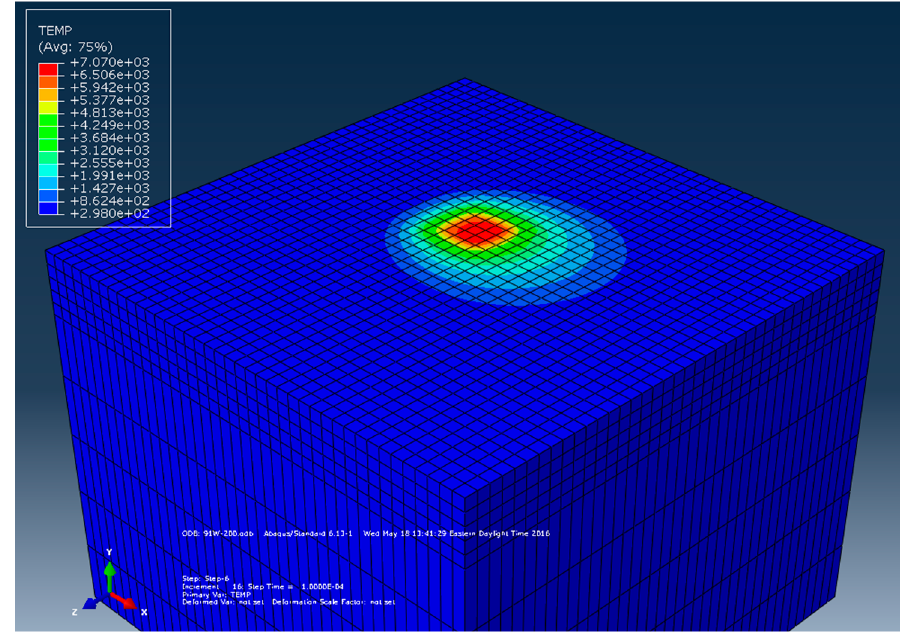
Figure 4. Surface temperature distribution at a laser power of 91 W with scanning speed, 200 mm/s.